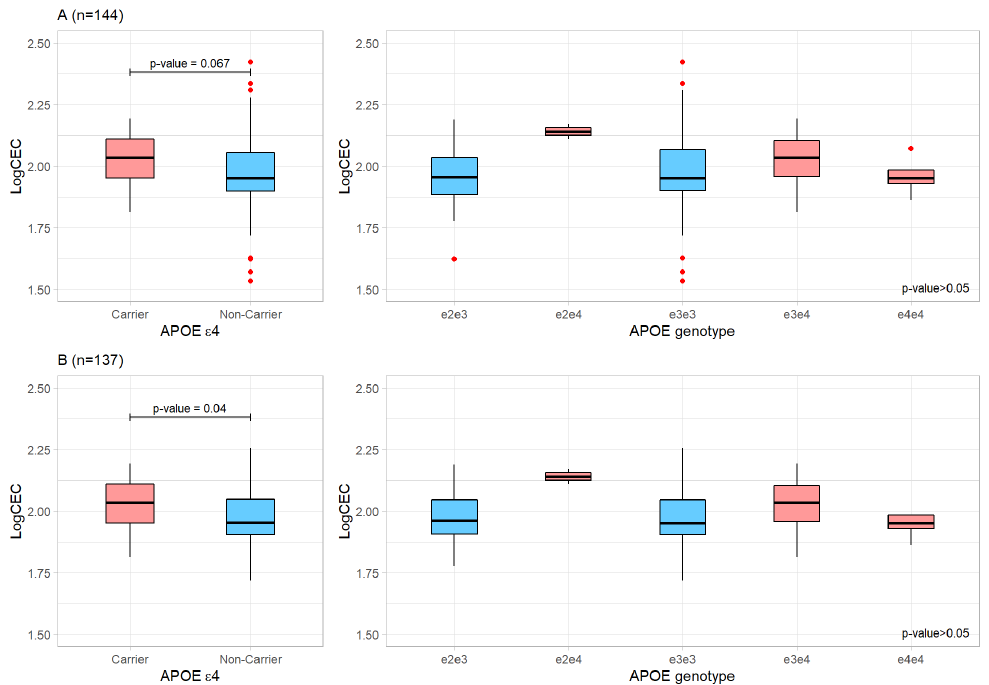
Figure 1. Cholesterol efflux capacity by APOE genotypes with ( A ) or without ( B ) CEC outliers. Left panels represent CEC values from APOE ε4 carriers vs. CEC values from APOE ε4 non -carriers. Right panels represent CEC levels in different APOE genotypes. Blue denotes non- ε4 categories. Red dots denote outliers identified.